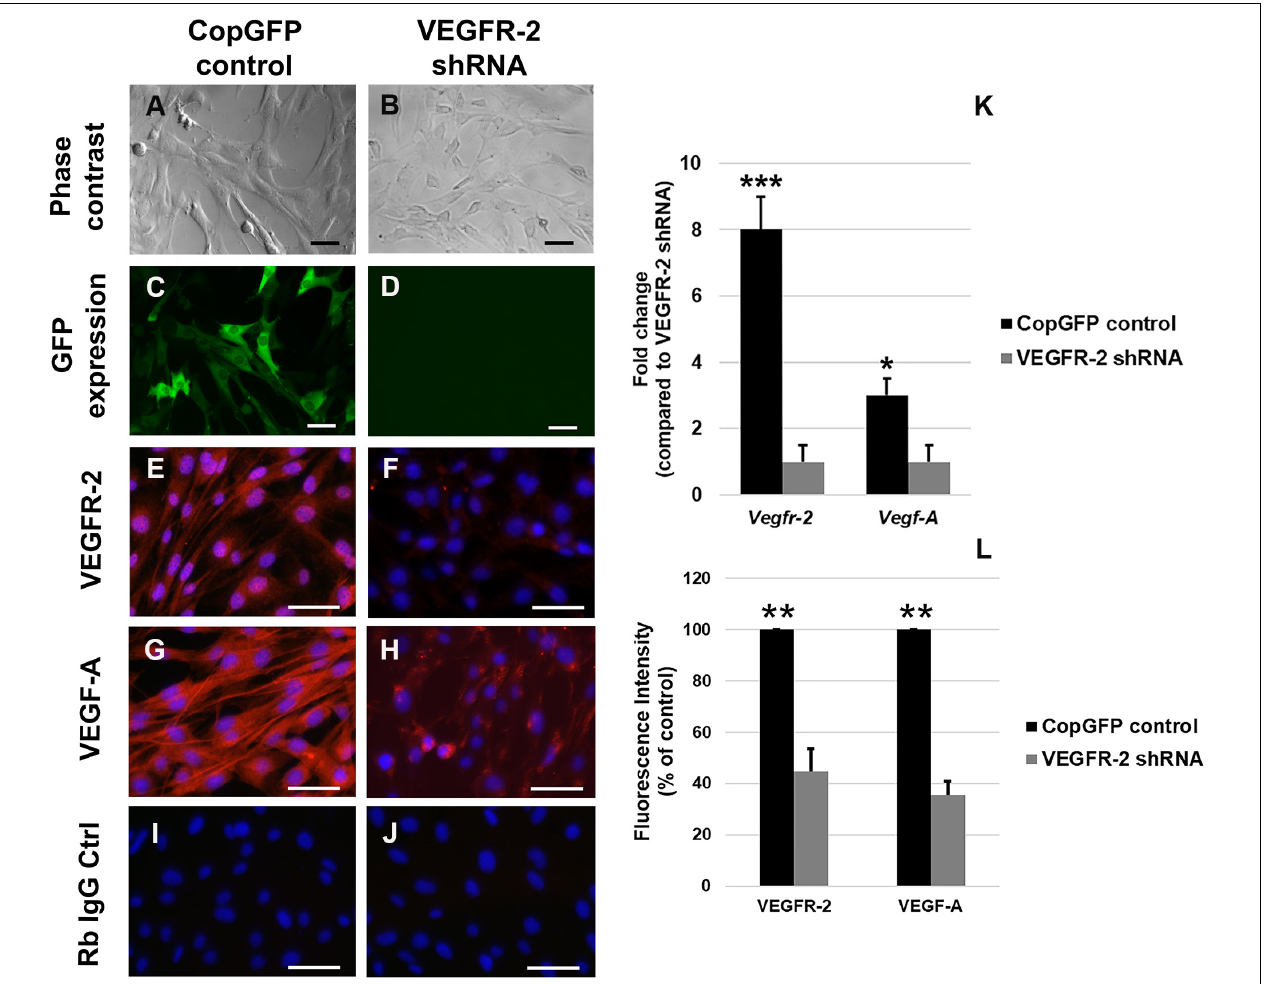
FIGURE 2 | Silencing of VEGFR-2 in murine DPSCs using the lentiviral vector. Murine DPSCs were transfected by either CopGFP control (A) or VEGFR-2 shRNA (B) lentiviral vectors with 10:1 of MOI (multiplicity of infection). After transfection, both groups exhibited their regular spindle shapes, presenting no toxicity of the viral vector. The 100% expression of GFP in CopGFP control (C) but not in VEGFR-2 shRNA group (D) was seen. The GFP+ expression in CopGFP DPSCs indicates the high efficiency of transfection. Immunofluorescence (in red) demonstrates strong positive staining of VEGFR-2 (E) and its ligand, VEGF-A (G) in CopGFP control DPSCs whereas there were very low expression of VEGFR-2 (F) and VEGF-A (H) in VEGFR-2 shRNA DPSCs. The rabbit IgG control (Rb IgG Ctrl) stained in CopGFP control (I) and VEGFR-2 shRNA DPSCs (J) were completely negative to confirm the specificity of antibodies. DAPI (in blue) was used for the nuclear staining. Scale bars indicate 100 µ m. The bar graph (K) reveals that real-time PCR analysis showed higher expression of both Vegfr-2 and Vegf-A in CopGFP control DPSCs, compared to that in VEGFR-2 shRNA treated DPSCs. Differences in gene expression is demonstrated as the fold change of that in VEGFR-2 shRNA DPSC group. GAPDH was used as the internal control. The bar graph (L) reveals the quantification of the VEGFR-2 and VEGF-A fluorescence intensity in both normal and VEGFR-2 knockdown DPSCs by using ImageJ software. The quantification showed a statistically significant decrease in VEGFR-2 and VEGF-A levels in VEGFR-2 knockdown DPSCs, compared to normal DPSCs. The results were shown as the fluorescence intensity (% of control). ***, **, * is used for significantly statistical difference at p -value < 0.001, 0.005, 0.05, respectively. The results represent the means ± SD ( n = 5 from each group/experiment) of three independent